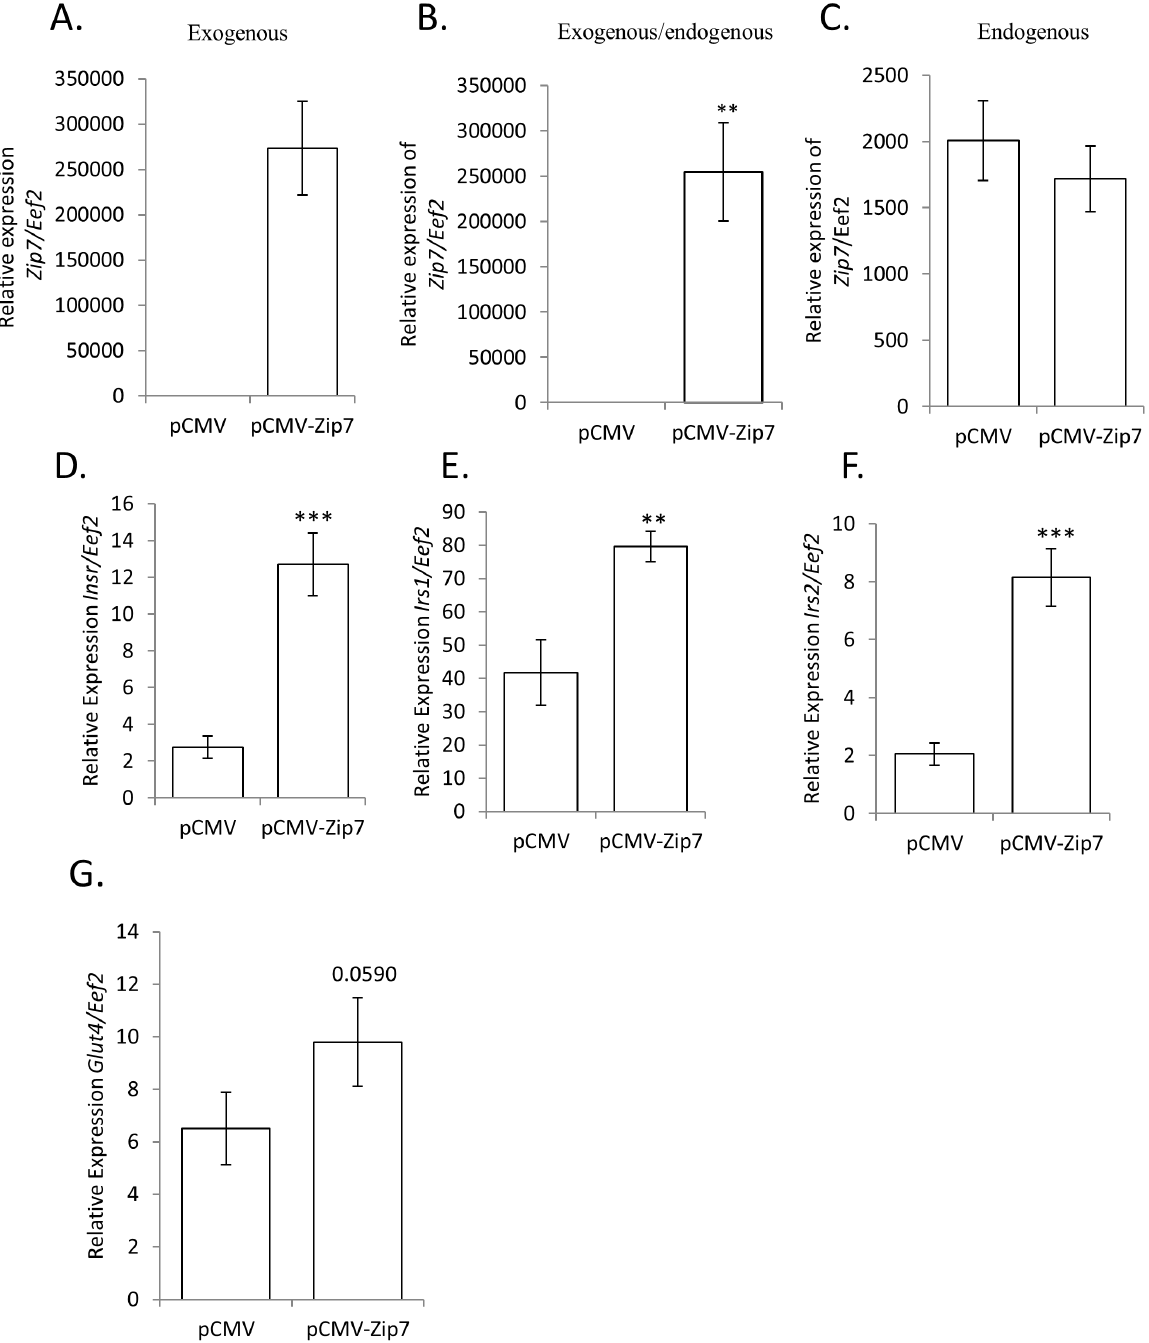
Figure 8. The exogenous overexpression of Zip7 mRNA induces the expression of the insulin receptor ( Insr ), insulin receptor substrate 1 ( Irs1 ), insulin receptor substrate 2 ( Isr2 ) and Glut4 mRNA. A. Relative expression of exogenous Zip7 mRNA. B. Relative expression of endogenous and exogenous Zip7 mRNA . C. Relative expression of endogenous expression of Zip7 mRNA. D-F. Relative expression of Insr, Irs1 and Irs2 mRNA. G. Relative expression of Glut4 mRNA (not significant P=0.0590). Error bars indicate the 6 SD from two independent biological samples for the mRNA analysis that consisted of at least three independent transfections. **P , 0.01, ***P , 0.001.